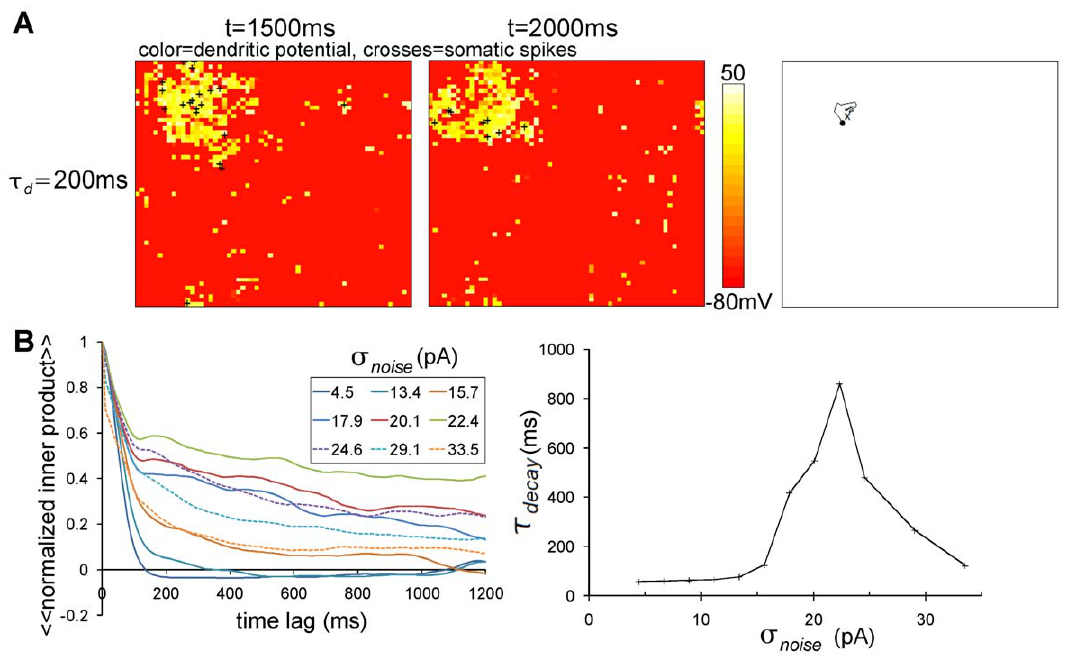
Figure 3. Bump remains immobile in noisy background condition with slow dendritic dynamics. (A) Snapshots at t ~ 1500 ms (leftmost) and 2000 ms (center) and the trajectory of bump from 1500 ms to 2000 ms (rightmost) in noisy background inputs ( s noise ~ 22 : 4 pA) with slow dendritic dynamics ( t d ~ 200 ms). The bump is practically immobile. (B) The decay of the inner product with time lag depends on the noise intensity, s noise . The left panel shows the decay curves of the inner product with a time lag for various values of s noise . The curves were obtained by temporal and trial average of the time lag-dependent inner products expressed by SS : TT . The right panel shows the dependence of the decay time constant calculated by curves of the inner product on s noise . t d ~ 200 ms.